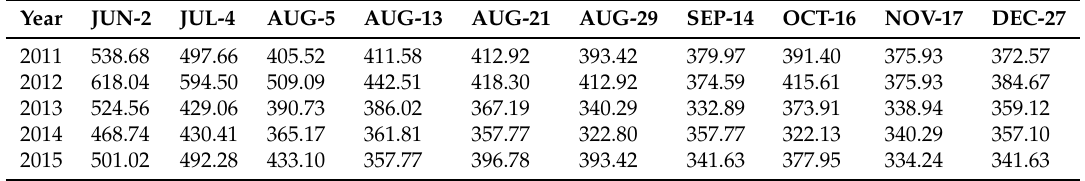
Table 4. Model performance of the long short-term memory (LSTM) measured in RMSE, 2011–2015.